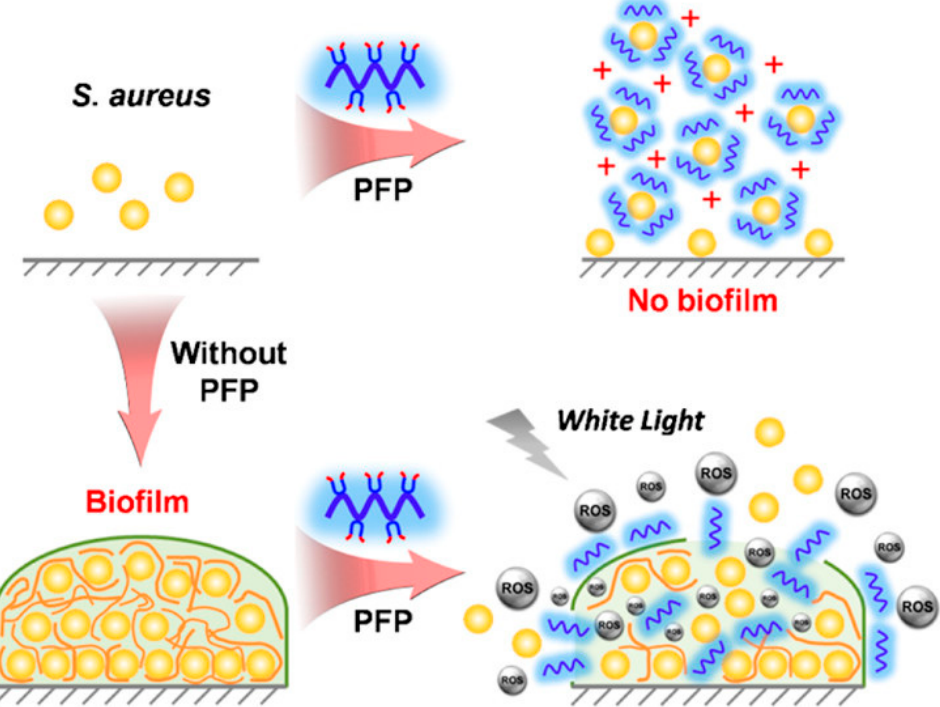
Figure 8. Scheme for the activity of water-soluble PFP (poly-{[(9,9-bis(6’- N , N , N -trimethylammonium)hexyl) fluorenylene phenylene]dibromide}) conjugated polymers against S. aureus planktonic cells as reproduced from reference [146]. Reprinted with permission from [146]. Copyright (2017) American Chemical Society.